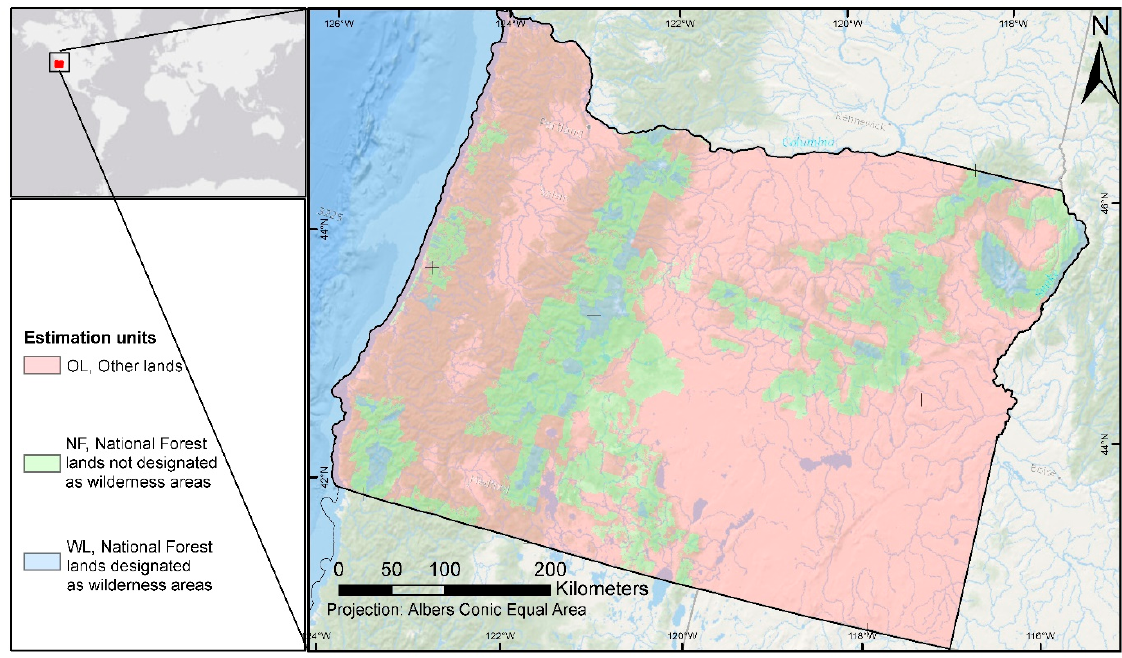
Figure 1. Location of the study area, outlined in black, and Estimation Units, EU, defined by the US Forest Service Forest Inventory and Analysis program in Oregon. OL, Other lands, NF, National Forest, lands not designated as wilderness areas (intensified sample), and WL, National Forest lands designated as wilderness areas.